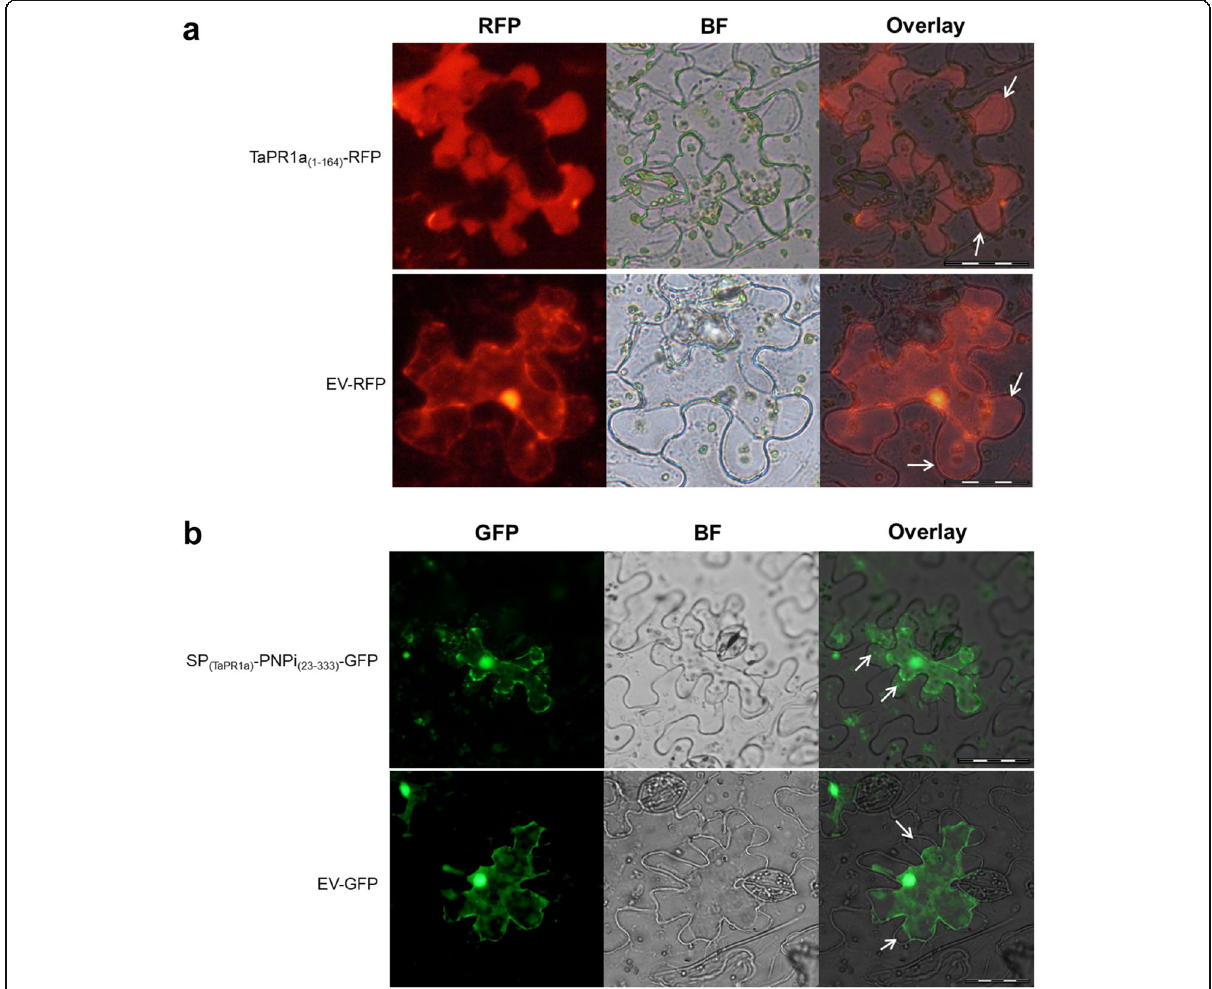
Fig. 2 Subcellular localization of TaPR1a and SP (TaPR1a) -PNPi (23 – 333) in N. benthamiana epidermal cells. a The TaPR1a (1 – 164) -RFP recombinant segment was transiently expressed in N. benthamiana leaves by agroinfiltration. b SP (TaPR1a) -PNPi (23 – 333) -GFP was transiently expressed in tobacco leaves. RFP or GFP alone was used as a control. Leaf epidermal peels were plasmolyzed (white arrows) by incubation in 800 mM mannitol for 6 min. BF, bright field; EV, empty vector; RFP, red fluorescent protein; GFP, green fluorescent protein. Scale bar = 100 μ